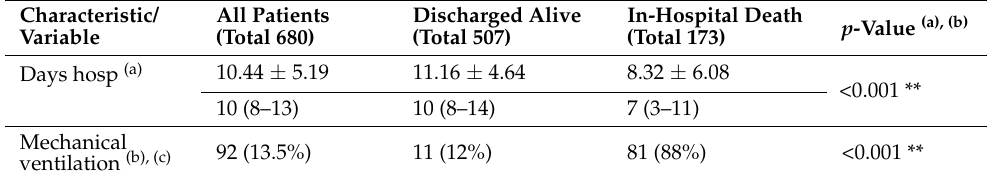
Table 3. Length of hospitalization and mechanical ventilation in relation to in-hospital mortality. Characteristic/